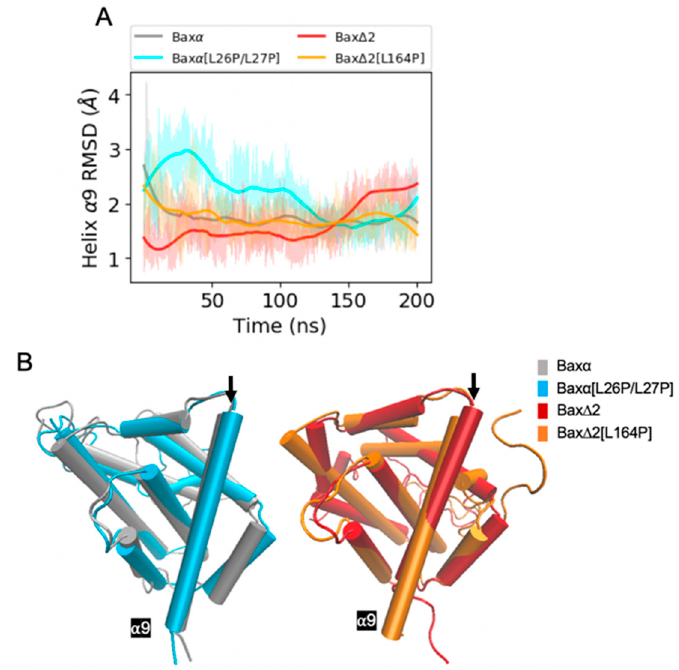
Figure 4. RMSD analysis of helix α 9. ( A ) RMSDs of Bax variant helix α 9 backbone atoms relative to the initial structure for a period of 200 ns of MD simulations. Shaded lines show RMSDs for all recorded points and solid lines are smoothed as described in Section 4.4. Similar plots for two additional repetitions of the simulations are shown in the bottom right panels of Figures S2 and S3. ( B ) Representative structures of Bax variants. The black arrow points at helix α 9.